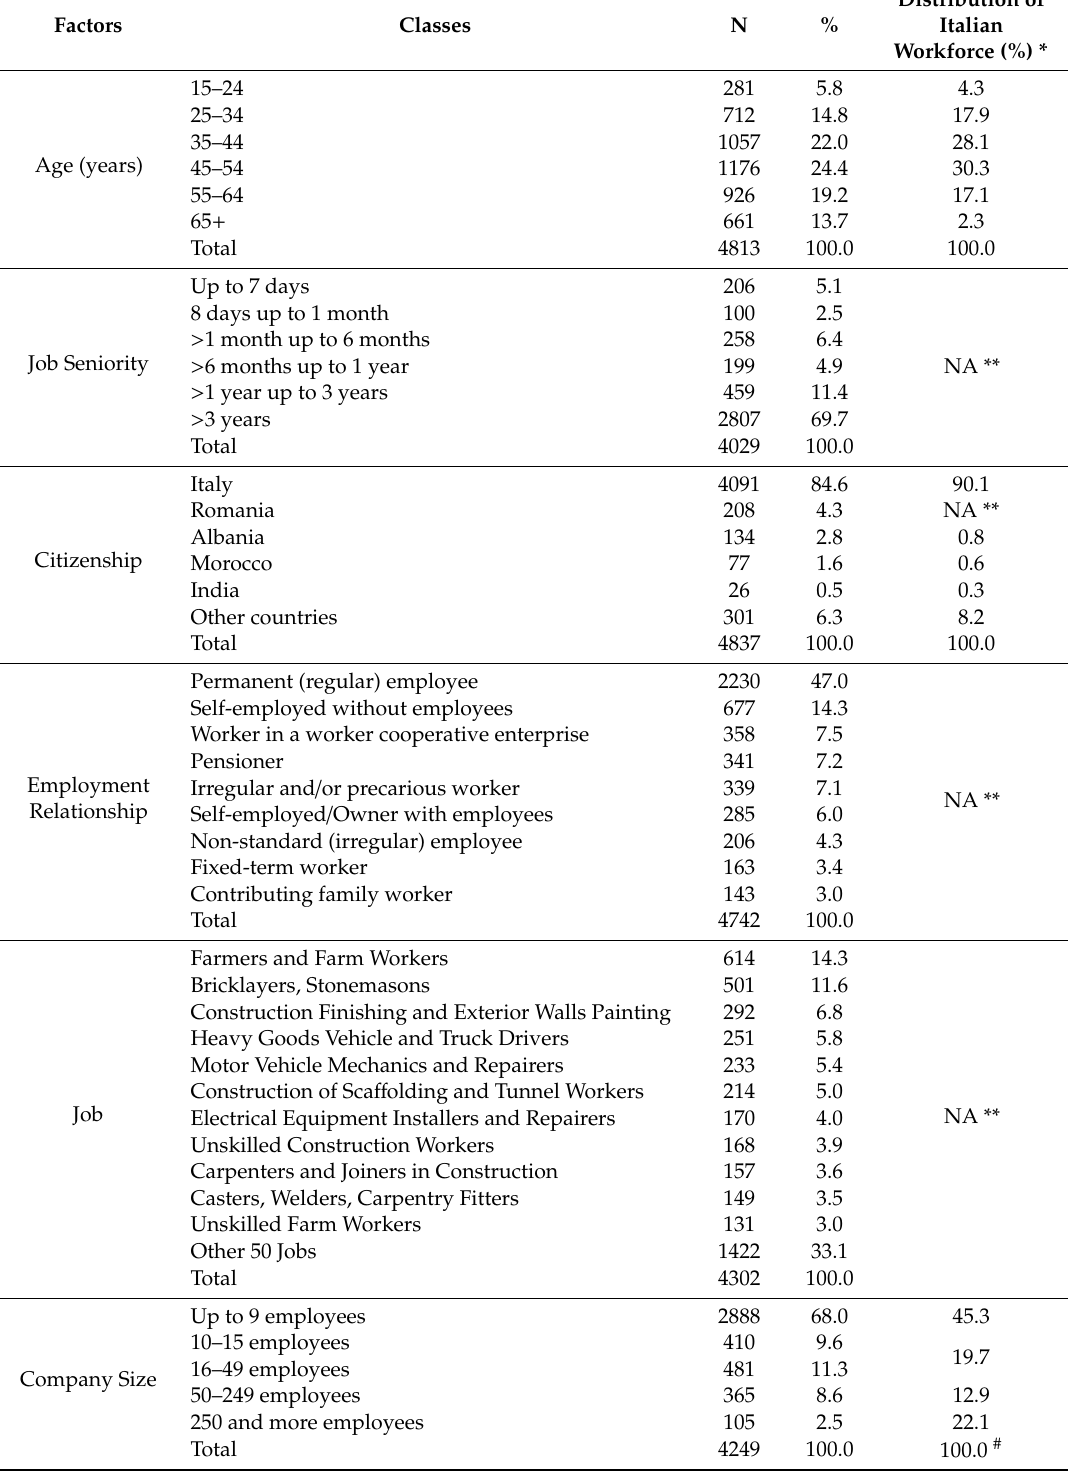
Table 1. Number (N) and column percentage (%) of fatal injuries in relation to the most important characteristics of the injured worker and their company /